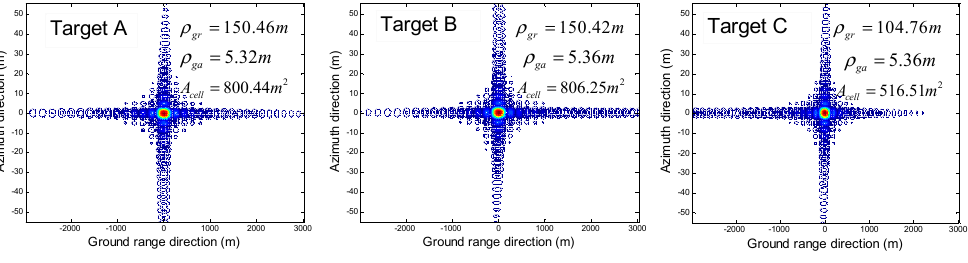
Figure 9. Simulated point target responses of the forward quasi-specular bistatic.